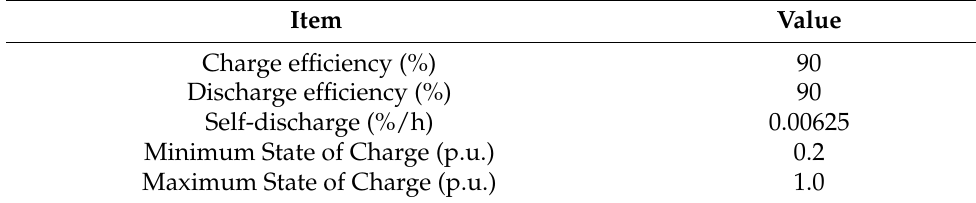
Figure 4. Clearing energy prices of the Colombia market (2019–2020). Table 1. Technical characteristics of Li-ion batteries used.